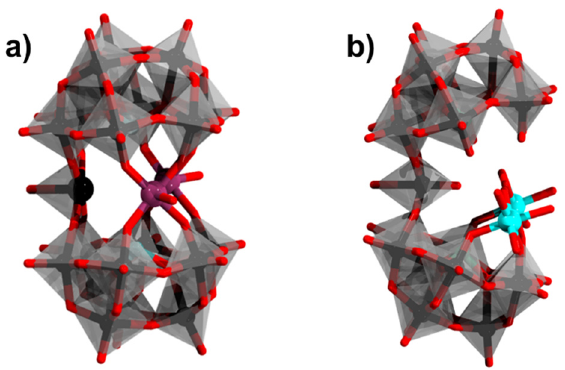
Figure 5. ( a ) [{Co 2 (H 2 O) 2 }{WO}( α -AsW 9 O 33 ) 2 ] 10 − ; ( b ) [{Ni(H 2 O) 4 } 2 {WO(H 2 O)}( α -AsW 9 O 33 ) 2 ] 9 − . Color code: As = green, Co = purple, Ni = cyan, {WO 6 } = gray octahedra, W = black, and O = red. Hydrogen atoms from aqua ligands are omitted.